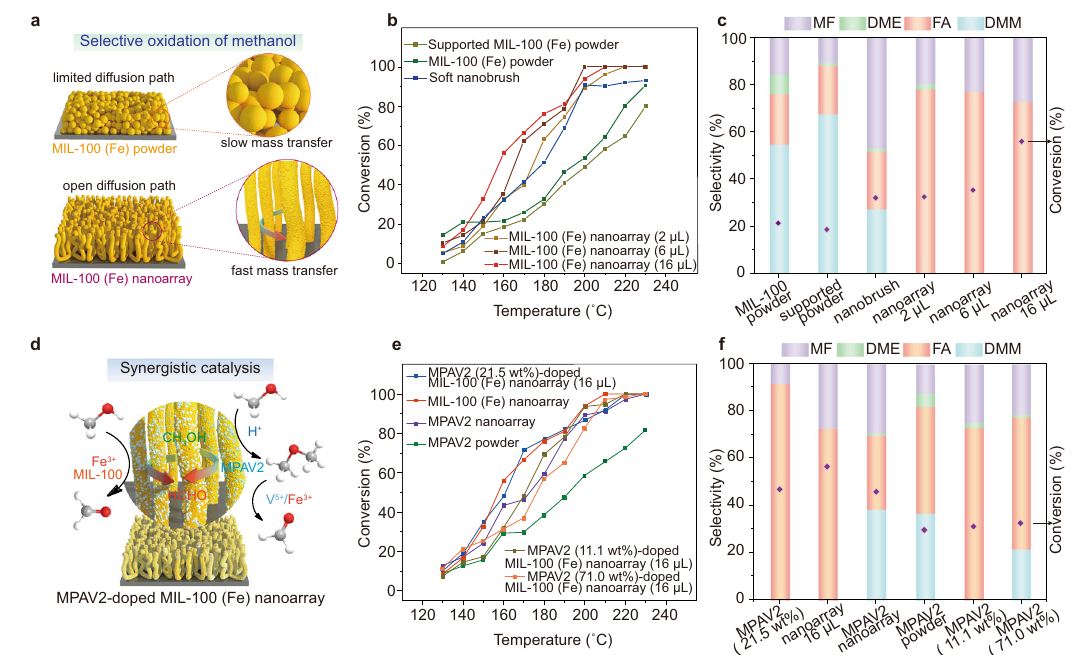
Fig. 5 | Selective oxidation of methanol catalyzed by MIL-100 (Fe) nanoarrays. a Schematic illustration of the catalytic environment of a MIL-100 (Fe) nanoarray andalayerofMIL-100(Fe)powder. b , c Temperaturedependenceofconversion( b ) andFAselectivity( c )at160°Cfortheoxidationofmethanolinthepresence ofthe pristineMIL-100(Fe)powder,MIL-100(Fe)powderimmobilizedonasiliconwafer, soft nanobrushes and MIL-100 (Fe) nanoarrays (2 µ L, 6 µ L, 16 µ L), respectively. d SchematicillustrationofthesynergisticcatalyticeffectbetweentheMIL-100(Fe)